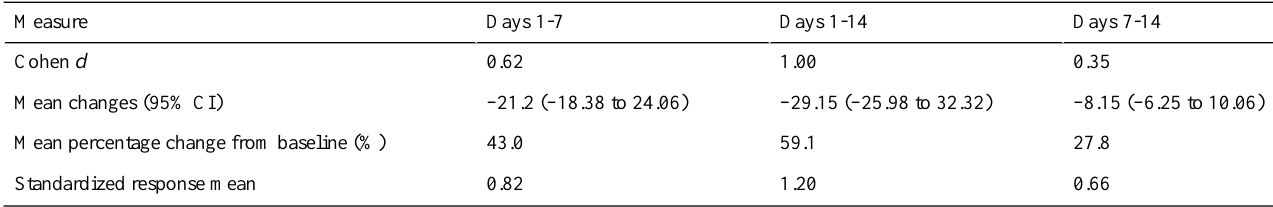
Table 4. Cohen d effect size, mean change, and standardized response mean, days 1-7, 1-14, and